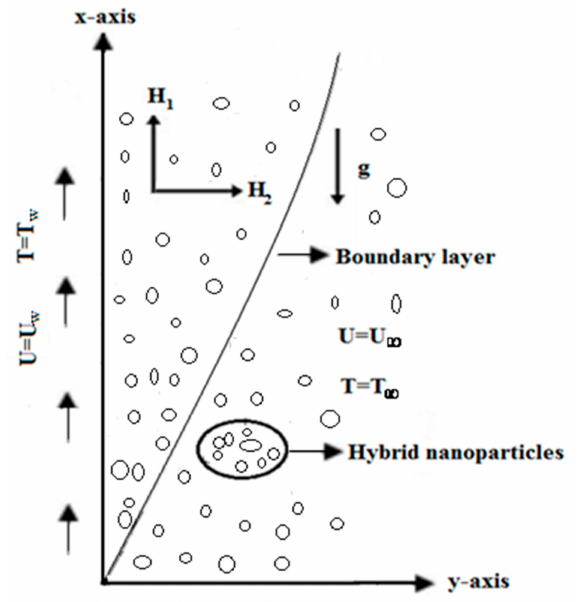
Figure 1. Geometrical interpretation of the